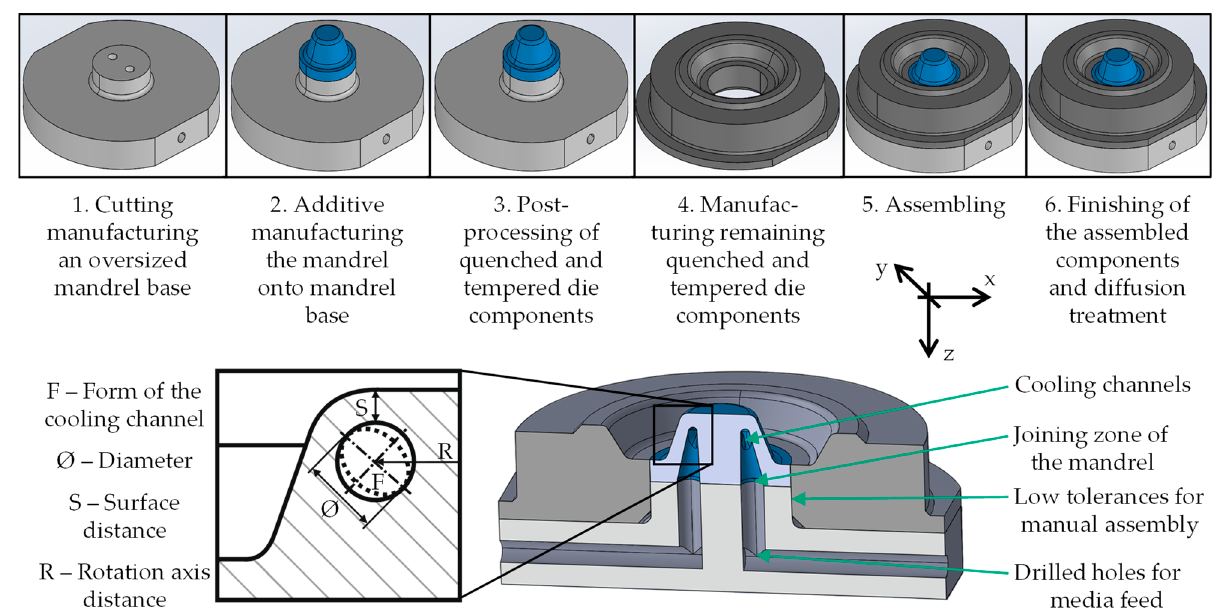
Figure 3. Design of L-PBF hybrid-forging dies and manufacturing sequence (in blue the L-PBF part).